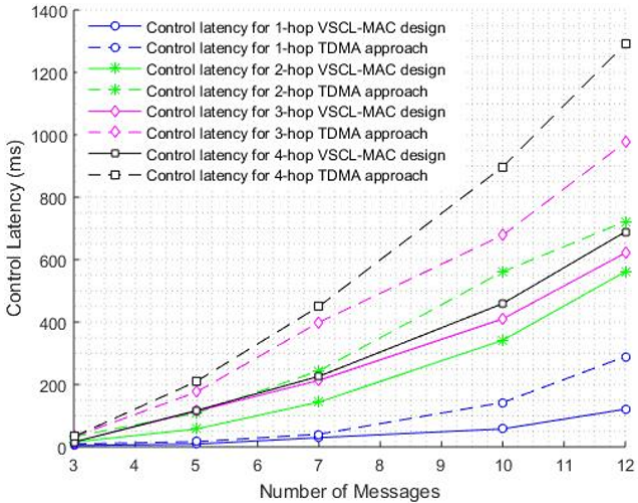
Figure 22. Control latency comparison between proposed design and conventional TDMA.